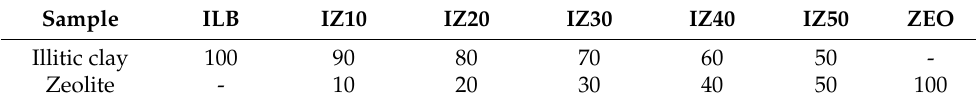
Table 2. The compositions of the samples made from Sedlec kaolin and natural zeolite (in